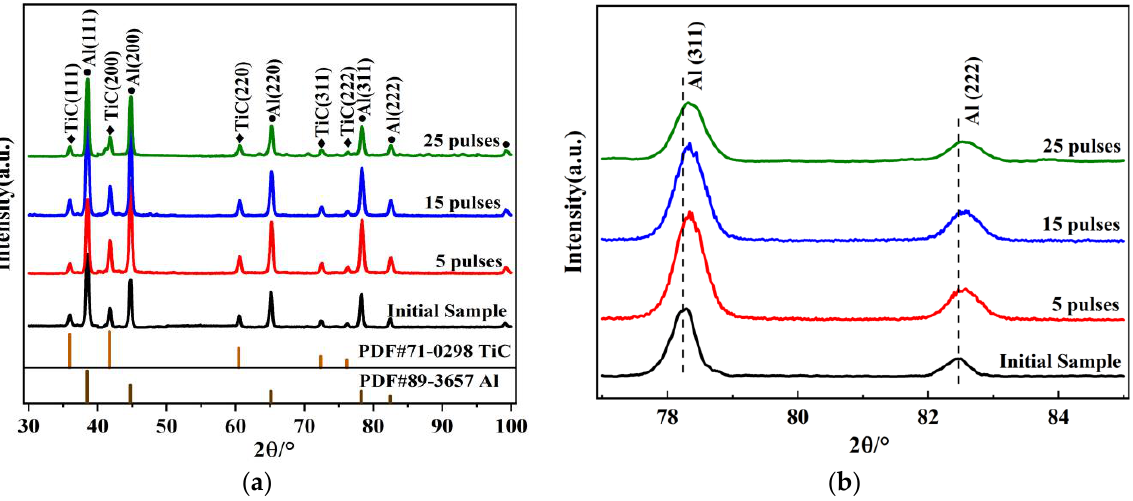
Figure 1. XRD patterns of Al-20TiC composites before and after HCPEB treatment: ( a ) complete XRD pattern; ( b ) local enlargement.